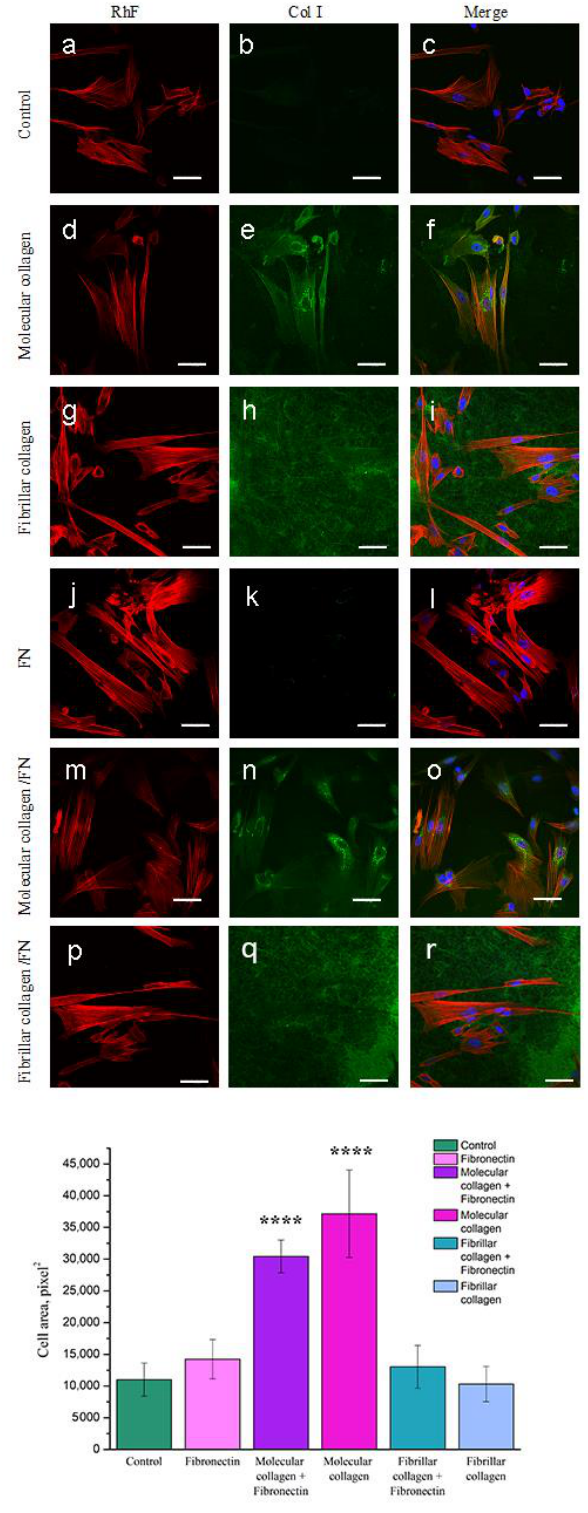
Figure 6. Fluorescence micrographs of MSCWJ-1s with actins (red), collagen fibrils (green) and nuclei (blue) stained after one days of cultivation on molecular and fibrillar collagen with/without fibronectin (FN): control (cover glass) ( a – c ), molecular collagen ( d – f ); fibrillar collagen ( g – i ); fibronectin ( j – l ); molecular collagen + fibronectin ( m – o ); fibrillar collagen + fibronectin ( p – r ). Statistics of cell area (spreading) on molecular and fibrillar collagen with/without fibronectin after 1 day cultivation. (n = 7 – 21: **** — p < 0.0001 compared with the control). Scale bar 50 µm.